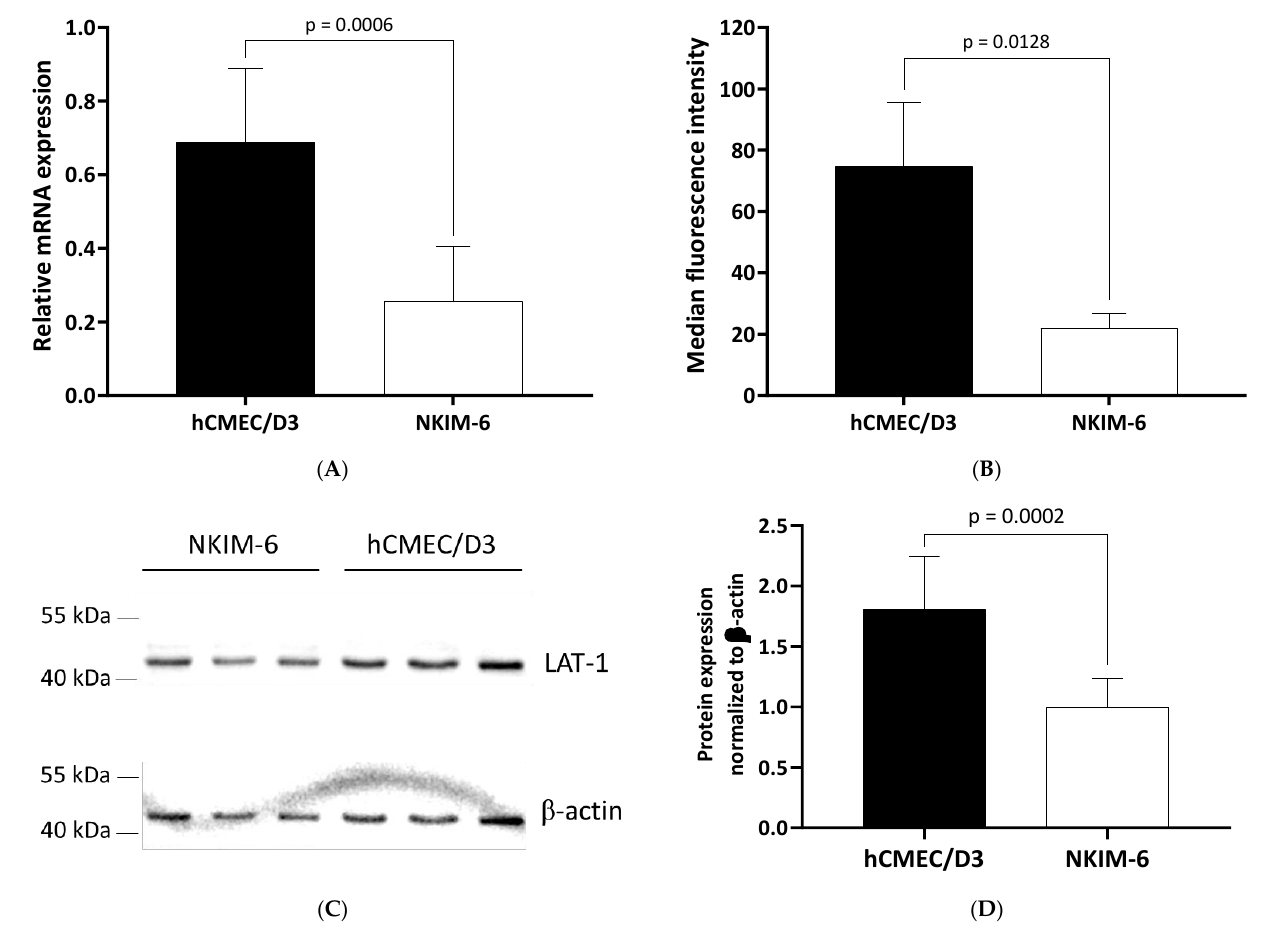
Figure 5. Expressional differences of SLC7A5 and SLC3A2/CD98 between hCMEC/D3 and NKIM-6 cell lines. ( A ) Normalized levels of SLC7A5 mRNA. Data are the mean ± SD of at least five biological replicates per cell line with two technical replicates each. ( B ) Median fluorescence intensity measured by flow cytometry of cells stained with PE-conjugated mouse anti-human CD98 antibody. Data are the mean ± SD from the median of three independent experiments. Statistical analyses were performed with unpaired t -tests. ( C ) Representative immunoblot of LAT-1 in NKIM-6 and hCMEC/D3. Bands of LAT-1 and β -actin are seen at the expected molecular weight of 40 and 42 kDa, respectively. For each cell line, three cell passages are shown: for NKIM-6 passages 50, 52, 53, for hCMEC/D3 32, 28, 33 (from left to right). ( D ) Quantitative analysis of three Western blots. Arbitrary units of LAT-1 bands were normalized to corresponding β -actin bands. Data are shown as mean ± SD of fold changes to the mean of the NKIM-6 values.